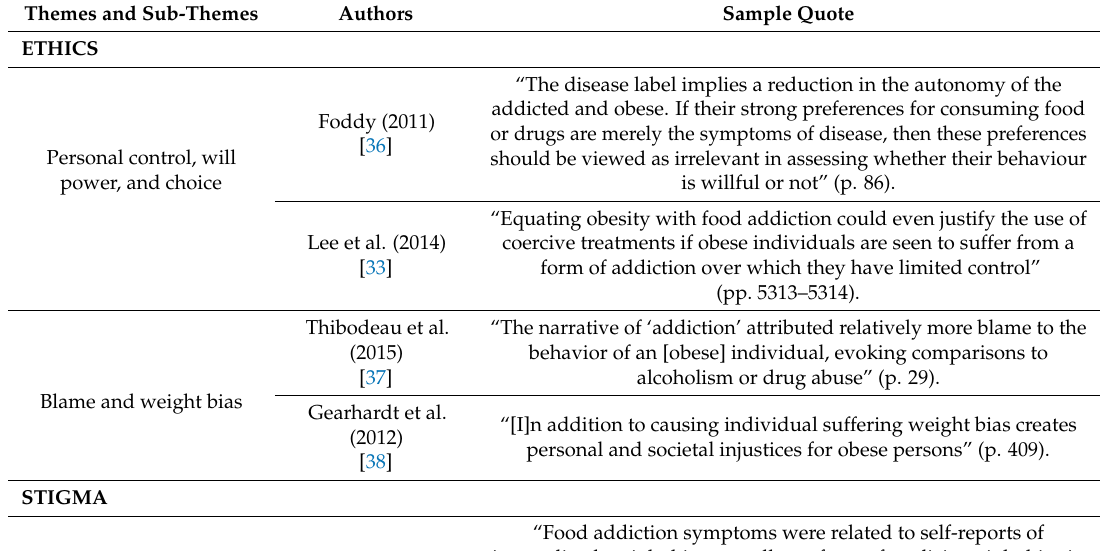
Table 1. Scoping review themes, subthemes, and representative